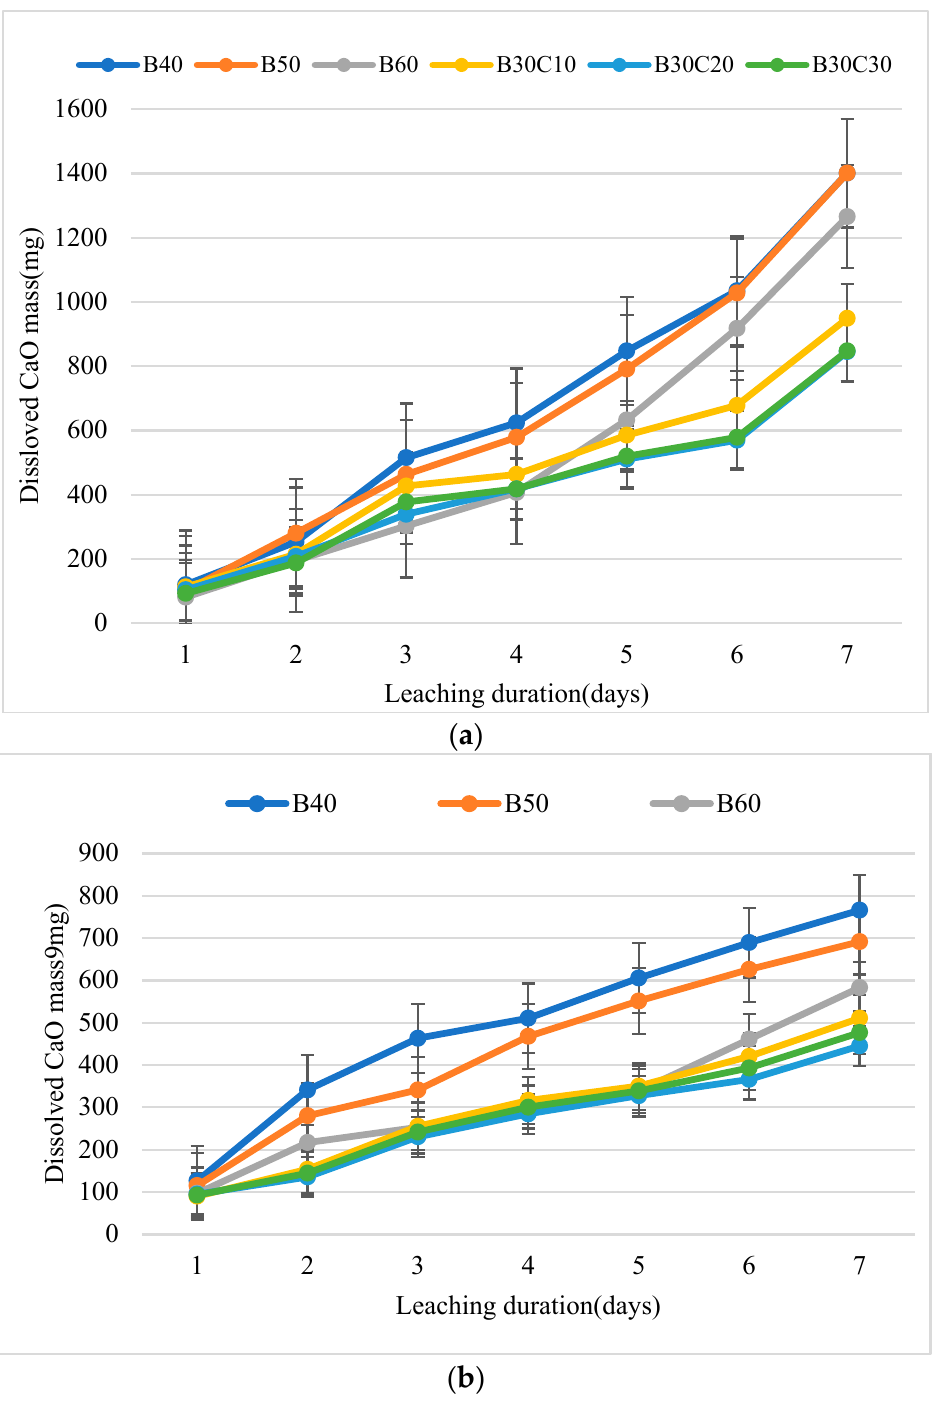
Figure 6. Calcium oxide dissolution mass leaching time curve. ( a ) First week ( b ) second week.